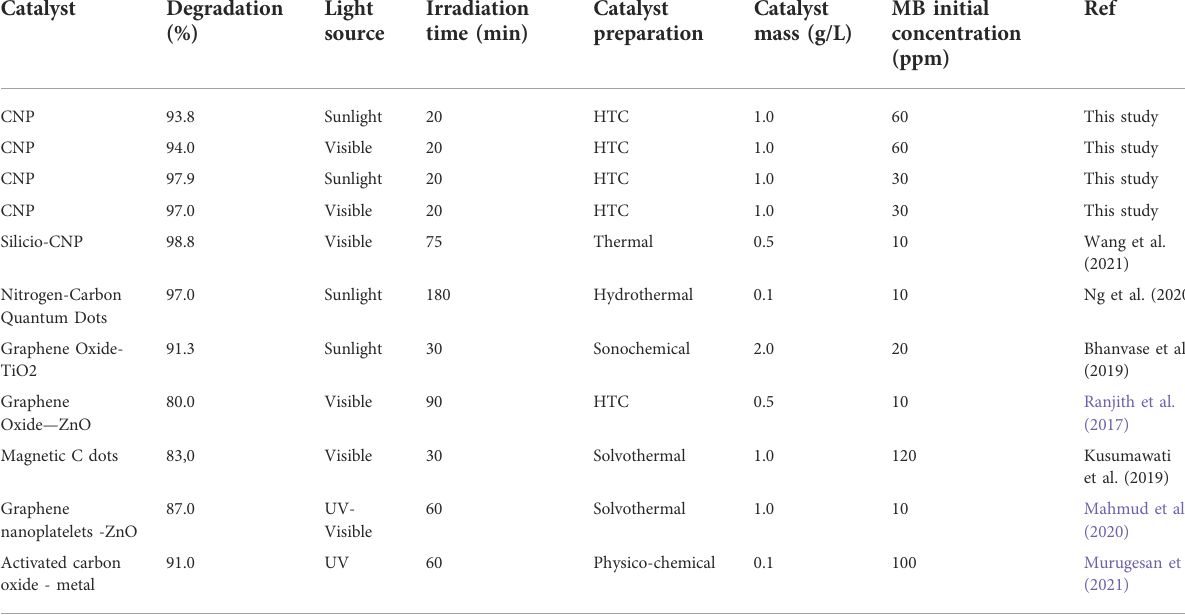
TABLE 1 Comparison of results obtained for the degradation of MB with different